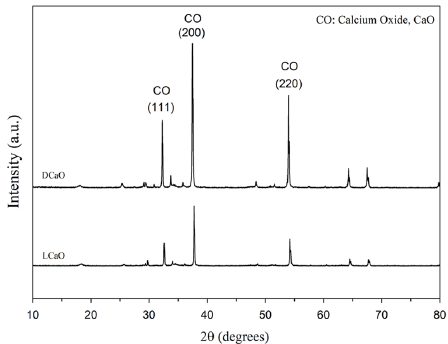
Figure 2. XRD pattern of light-burnt CaO and dead-burnt CaO. Table 1. Chemical compositions of ladle slag and fly ash. Ladle Slag Fly Ash